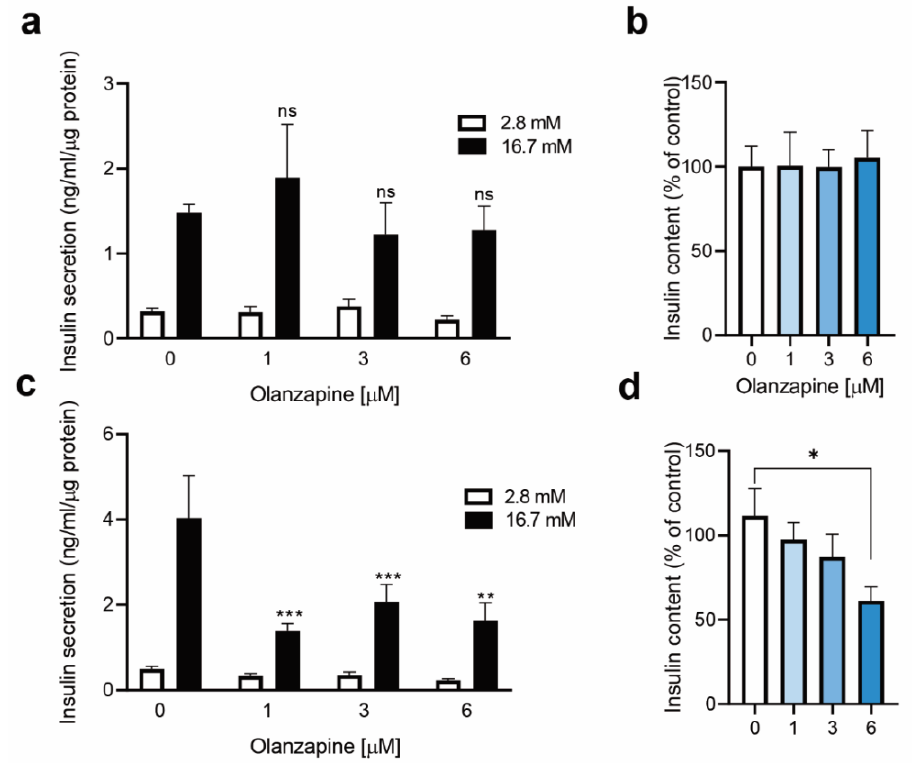
Figure 3. Effects of 4 or 24 h treatment with olanzapine on GSIS and insulin content in INS-1 beta cells. ( a ) GSIS in INS-1 beta cells upon olanzapine treatment for 4 h. ( b ) Insulin content at 4 h of